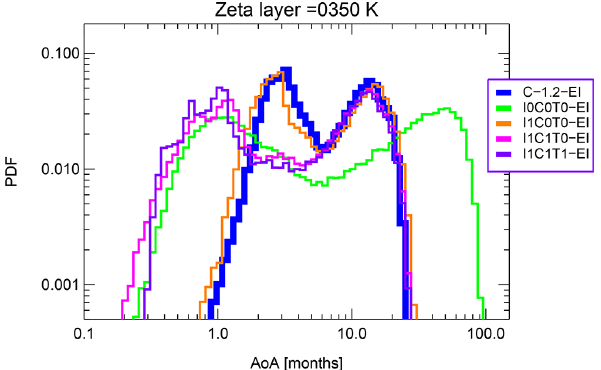
Figure 10. The probability distribution functions (PDFs) of age of air (AoA) after 14yr of perpetuum runs averaged over all APs within the CLaMS layer around ζ =